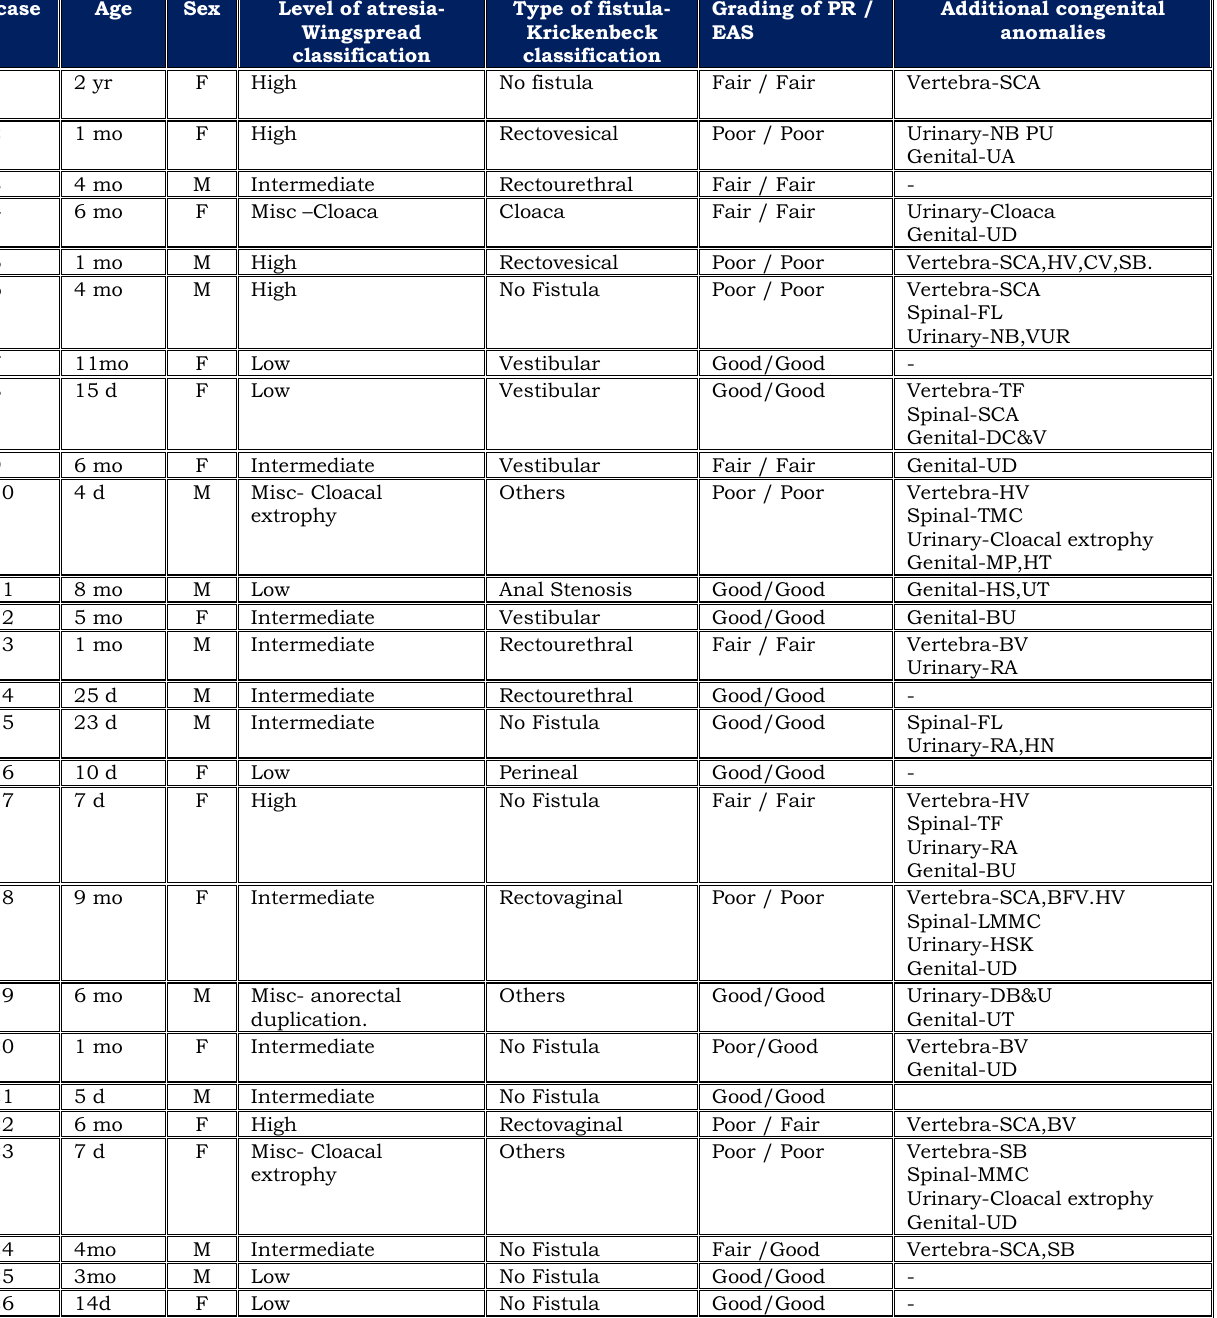
Table 2. The MRI findings in the 26 patients with